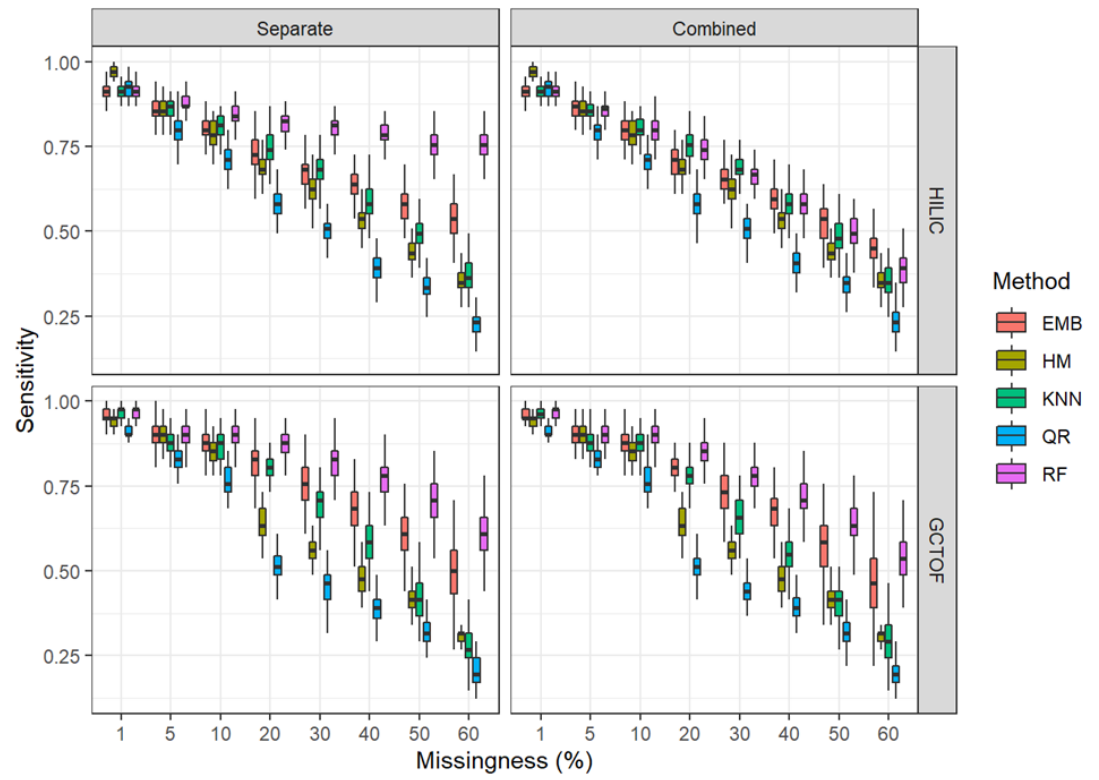
Figure 4. Box and whisker plots for sensitivity for the HILIC and GCTOF data sets.